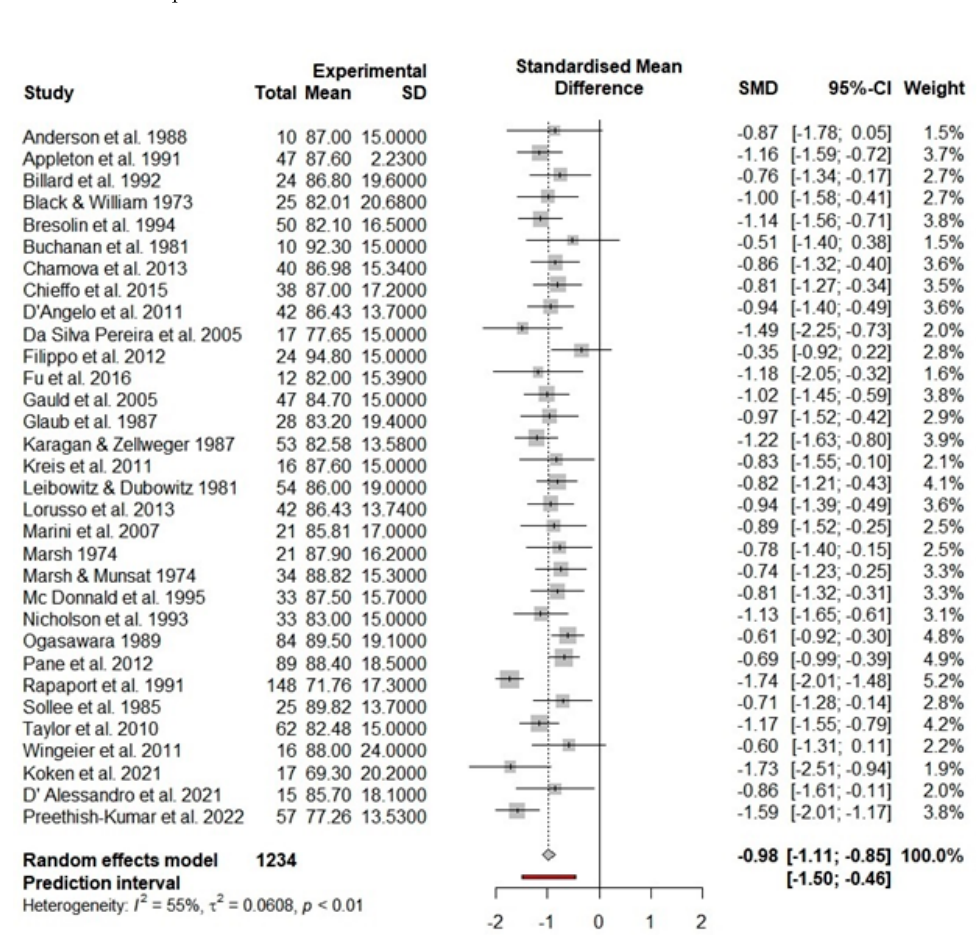
Figure 2. Forest plot of full-scale intelligence scores in the DMD population. Abbreviations used: CI = confidence interval; p = significance level; SMD = standard mean difference; SD = standard deviation [10,13,24,26,41,96–99,101–104,107–110,113–115,117,118,121–129]. Boys and men with BMD (k = 7) also had, on average, a significantly lower FSIQ compared to the means reported for the standardization sample (d = − 0.52, Z = − 2.54, 95%CI: − 0.92, − 0.12, p = 0.01), this translates into an average FSIQ of 92.11 points (95%CI: 86.71, 97.50; 95%PI: 79.63, 104.59) (Table 1). Heterogeneity between BMD studies was